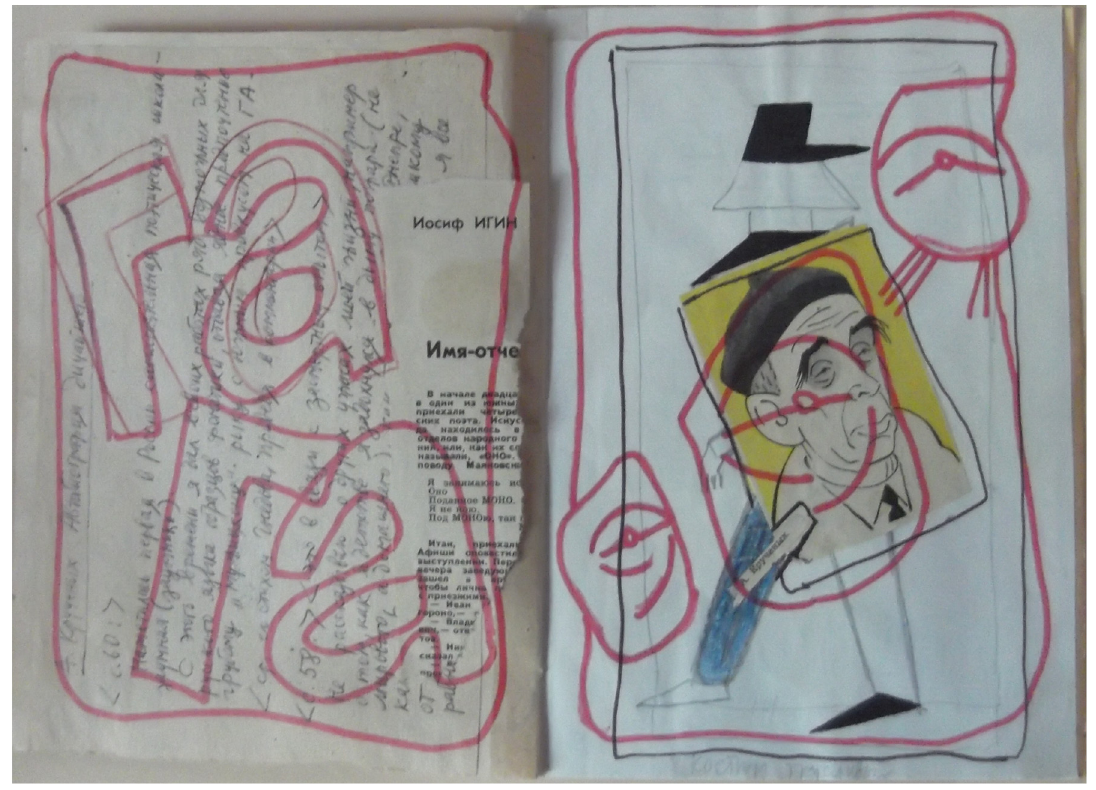
Figure 16. Pages from the second booklet.